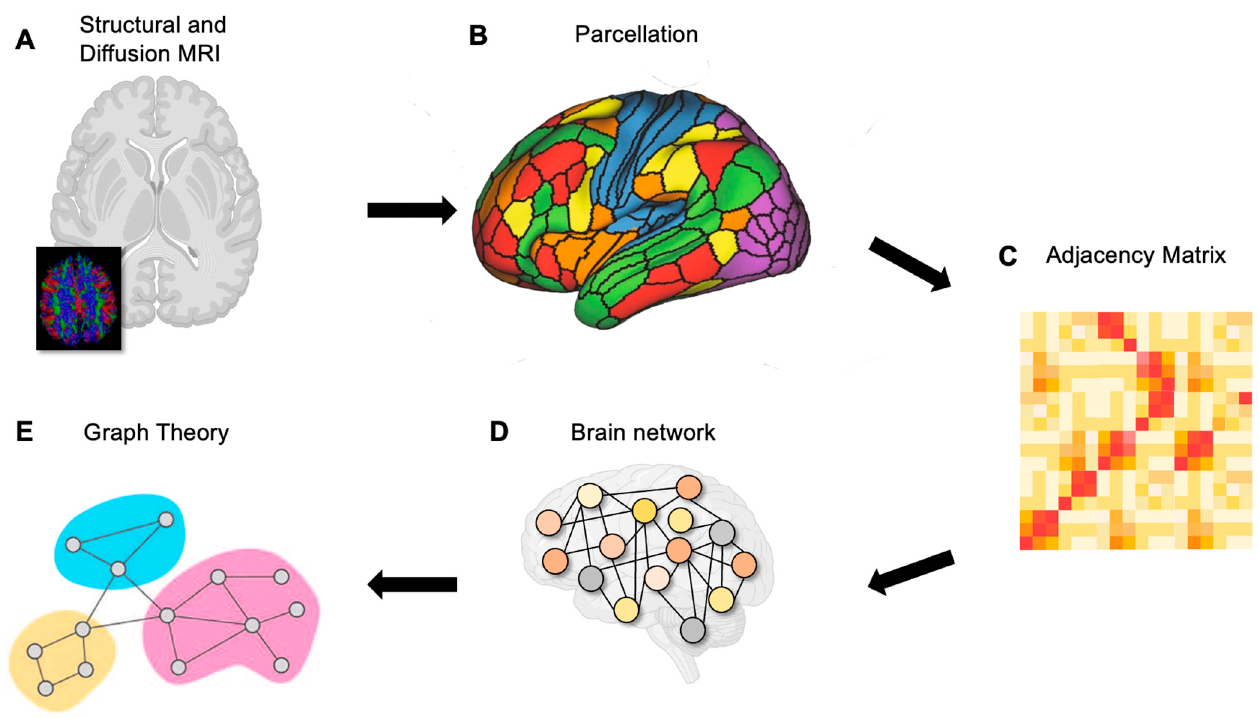
Figure 2. Schematic of brain network construction. ( A ) Neuroimaging data are used to estimate functional or structural connectivity using diffusion MRI, functional MRI, EEG, or MEG. ( B ) Parcellations are created based on T1 or T1-weighted structural MRI scans. A parcellation scheme is applied to define nodes. ( C , D ) The relationship between each pair of nodes is then represented as an adjacency matrix which can be used to construct a network of the brain. ( E ) Graph theory metrics can then be applied to the network to examine its topology. dMRI, diffusion magnetoencephalography; EEG, electroencephalography; MEG, magnetoencephalography; fMRI, functional magnetoencephalography. Figure adapted from Liao et al. (2017) [54] .